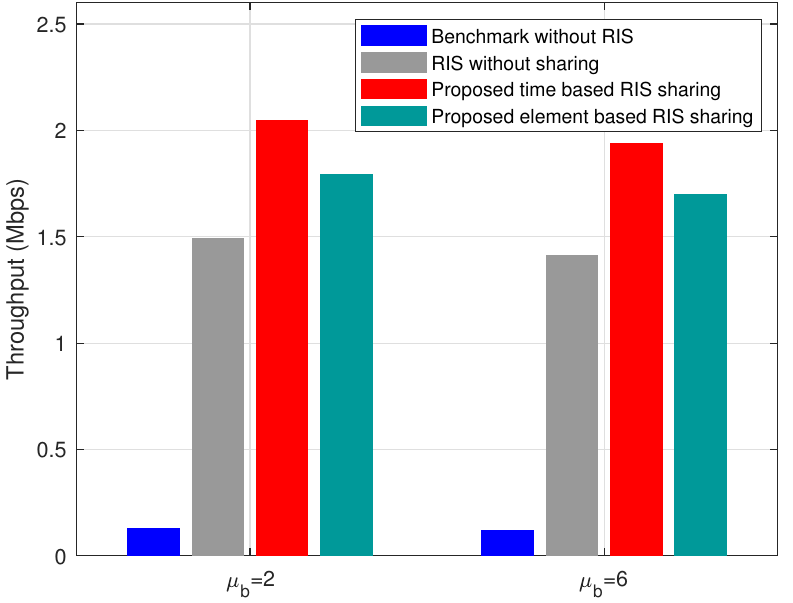
Figure 8. Variation of throughput with respect to blocker density µ b for µ pu = 20%, N = 40, µ b = 2, and α = 1.